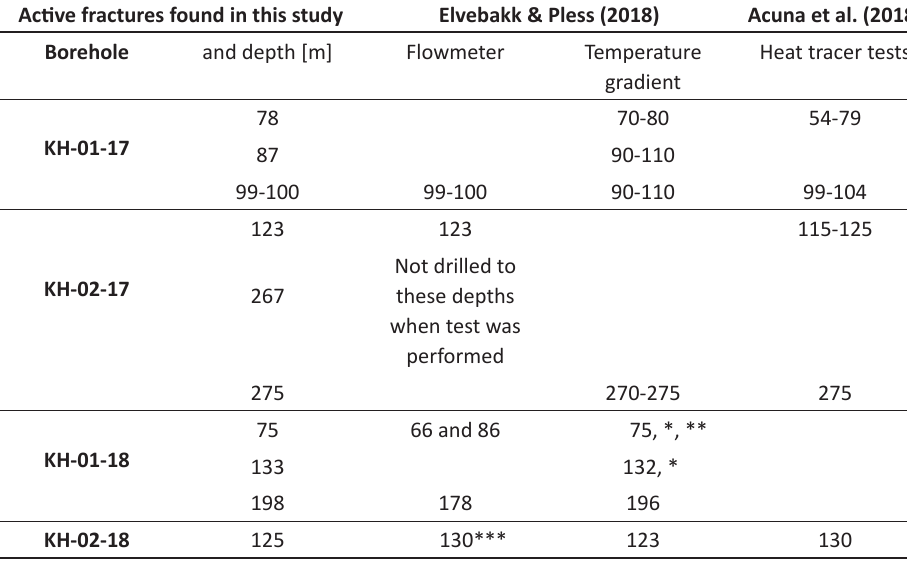
Table 4. Comparison of where active fractures were found in this study vs. two previous studies in the two borehole KH-01-17 and KH-02-17 at Åkneset, Norway: Depth values are approximate. *Changes in P- and S-waves found at the same depth. **Change in resistivity found at the same depth. *** No change in flowmeter value found at this depth, but consistent disturbance in flowmeter measurements both up and